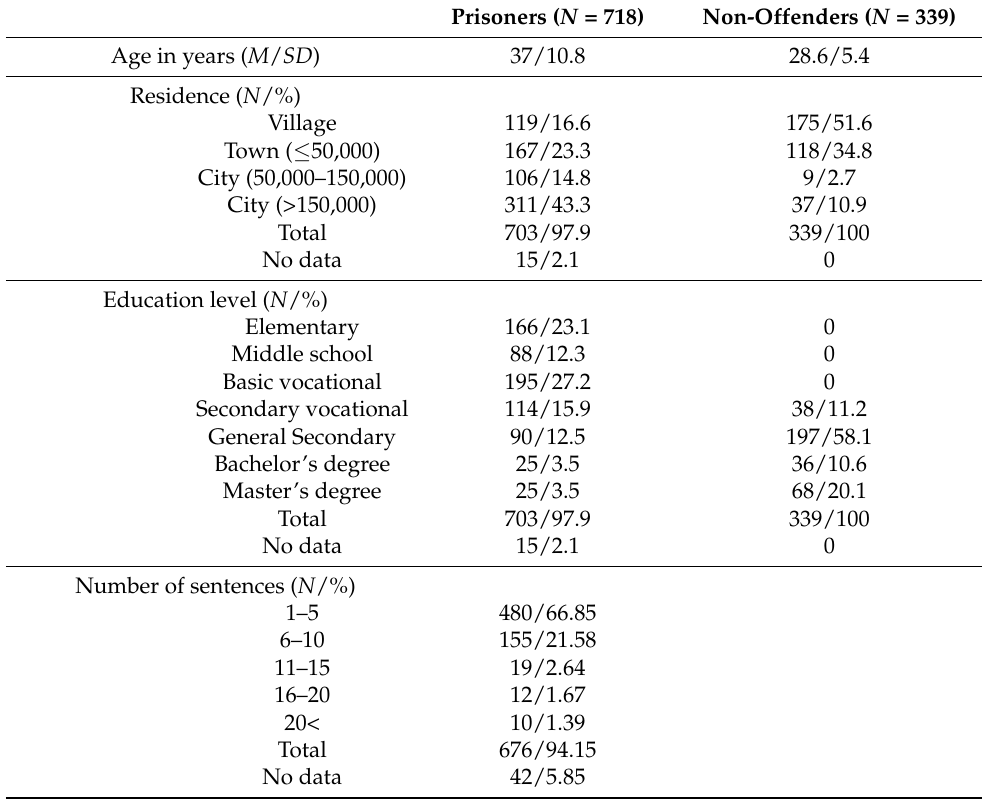
Table 1. Descriptive statistics for demographic